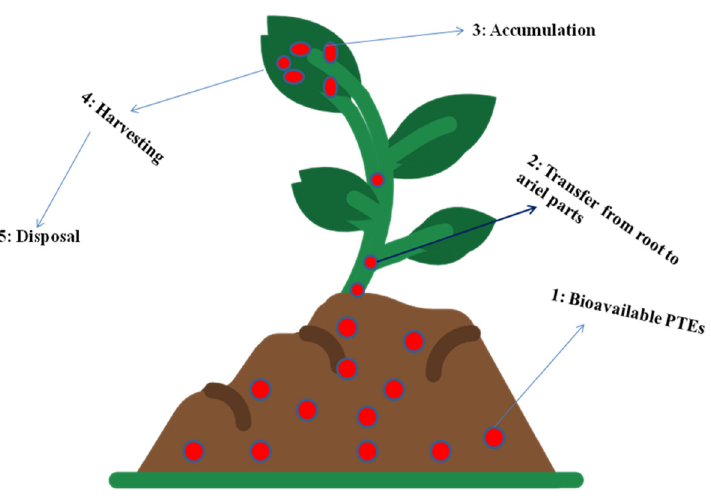
Figure 4. Representation of the major mechanisms underlying